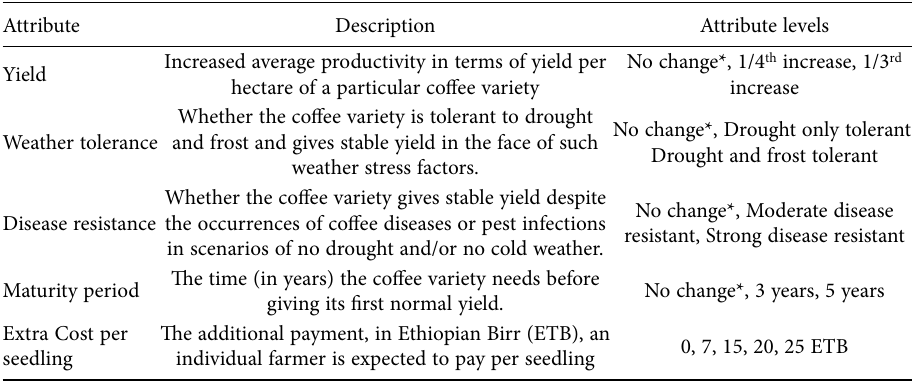
Table 2. Attributes and attribute levels, including the “no change” levels of the opt-out option, used in the discrete choice